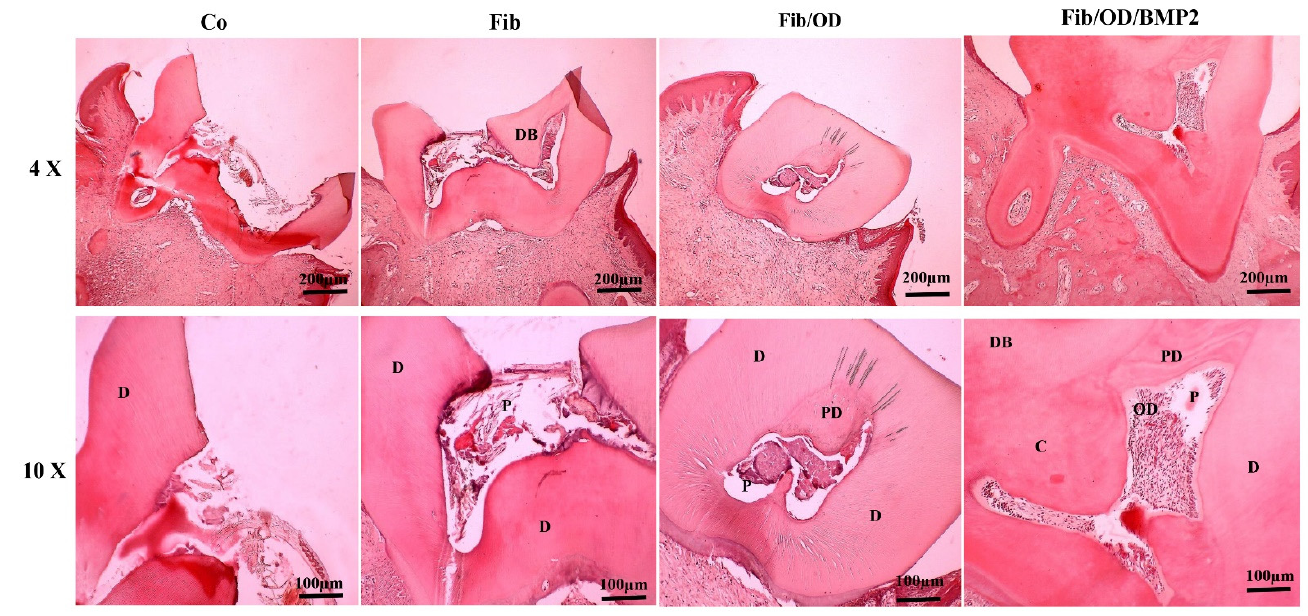
Figure 5. Analysis of the histomorphological results of the first molar by hematoxylin-eosin stain- ing after 8 weeks for various groups by magnification order. DB: dentin bridge, D: dentin, P: pulp, PD: predentin, OD: odontoblast, V: blood vessel, C: calcification.